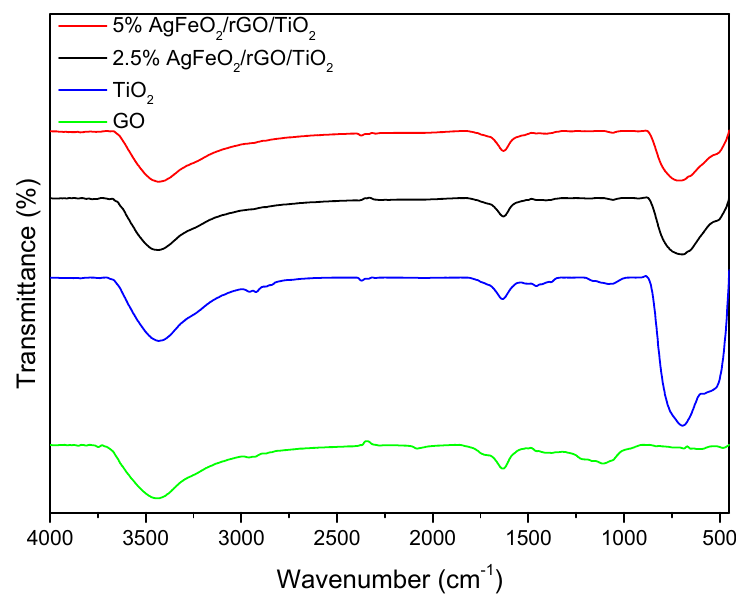
Figure 2. FTIR spectra of GO, Commercial TiO 2 , 2.5% AgFeO 2 / rGO / TiO 2 and 5% AgFeO 2 / rGO / TiO 2.